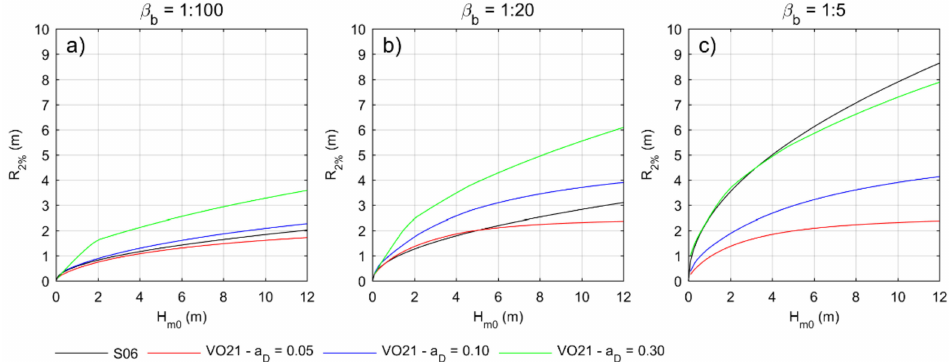
Figure 17. Comparison of R 2% run-up from this paper vs. Stockdon [8] for various cross − shore profiles and offshore wave conditions ( H m 0 varying, T p = 12 s). Panel ( a ): beach slope β b = 0.01. Panel ( b ): beach slope β b = 0.05. Panel ( c ): beach slope β b = 0.20. S06 [8] (black), this paper a D = 0.05 (red), a D = 0.10 (blue), a D = 0.30